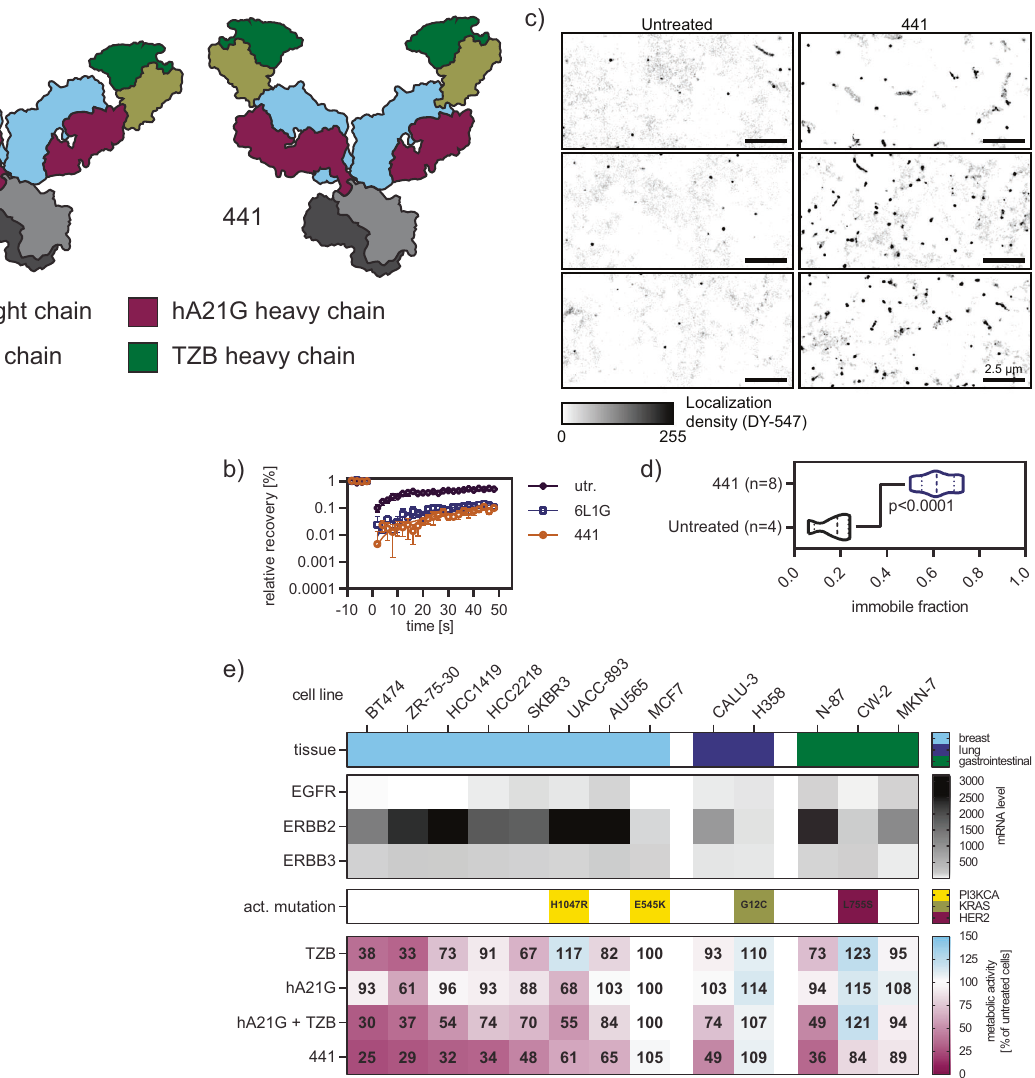
Fig. 2 Enhanced lockdown capacity and antiproliferative activity of scFv – IgG constructs. a Layout of tetravalent biparatopic constructs in the scFv – IgG format, based on scFv – Fab fusions 841 and 641. Construct 241 lacked effect compared to 441 (see Supplementary Fig. 3b) b FRAP of 441 (50 mM) treated cells ( n = 5 cells, error bar SEM) showed complete HER2 lockdown; untr untreated. c The effect of 441 on HER2 was further studied with single-molecule tracking experiments. Labeled Hela cells overexpressing a SNAP-tag HER2 fusion were analyzed with a TIRF-SMLM setup at room temperature. d The immobile fraction of HER2 was calculated to be 60% when analyzing single-molecule localizations of HER2 with the adapted DBSCAN algorithm. Two- sided unpaired t test with Welch ’ s correction demonstrated a signi fi cant difference from untreated cells (PBS only). e The additional antiproliferative activity of 441 over its parental antibody combination is seen across different cell lines and tissues (mean of n = 3), with relevant mutations indicated. The inhibitory effect of TZB, hA21G, and their combination on proliferation was only strong on certain HER2-dependent cell lines. 441, however, showed stronger reduction of viability throughout and thus a more universal response, hence indicating a bene fi t over the combination treatment. Source data are available in the Source Data fi